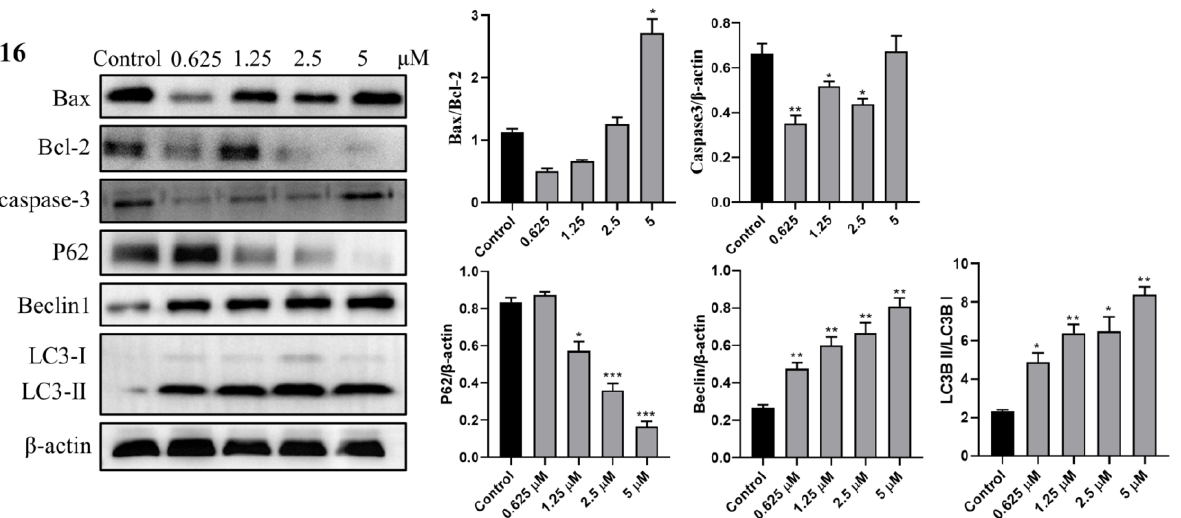
Figure 9. Effect of 16 on the expression of apoptotic (Bax, Bcl-2, and caspase-3) and autophagic related (p62, Beclin1, LC3-I, and LC3-II) proteins in HCT-15 cells. Quantitative histogram analysis of protein expression. *: p < 0.05, **: p < 0.01, ***: p < 0.001 vs. control group.